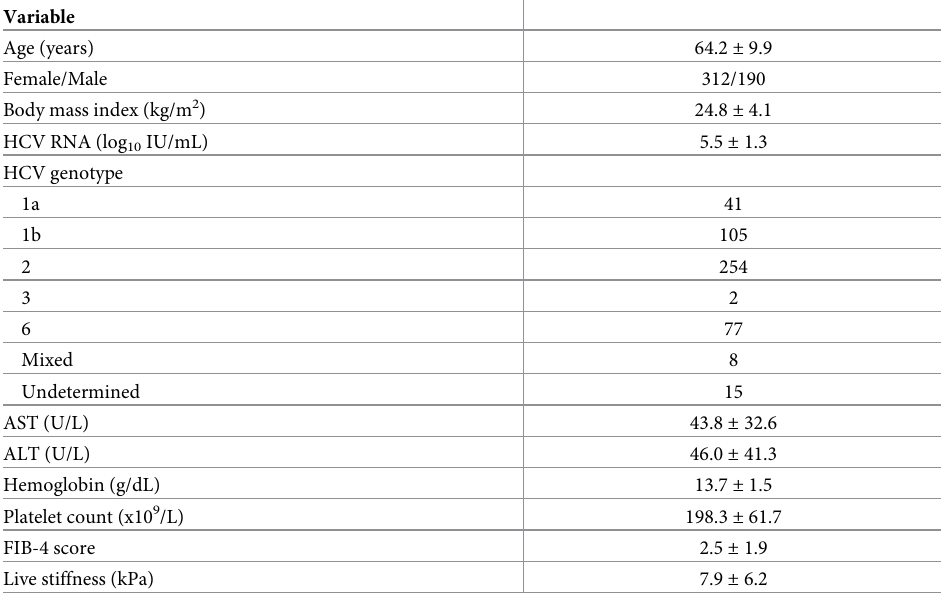
Table 1. Baseline characteristics of 502 HCV viremic